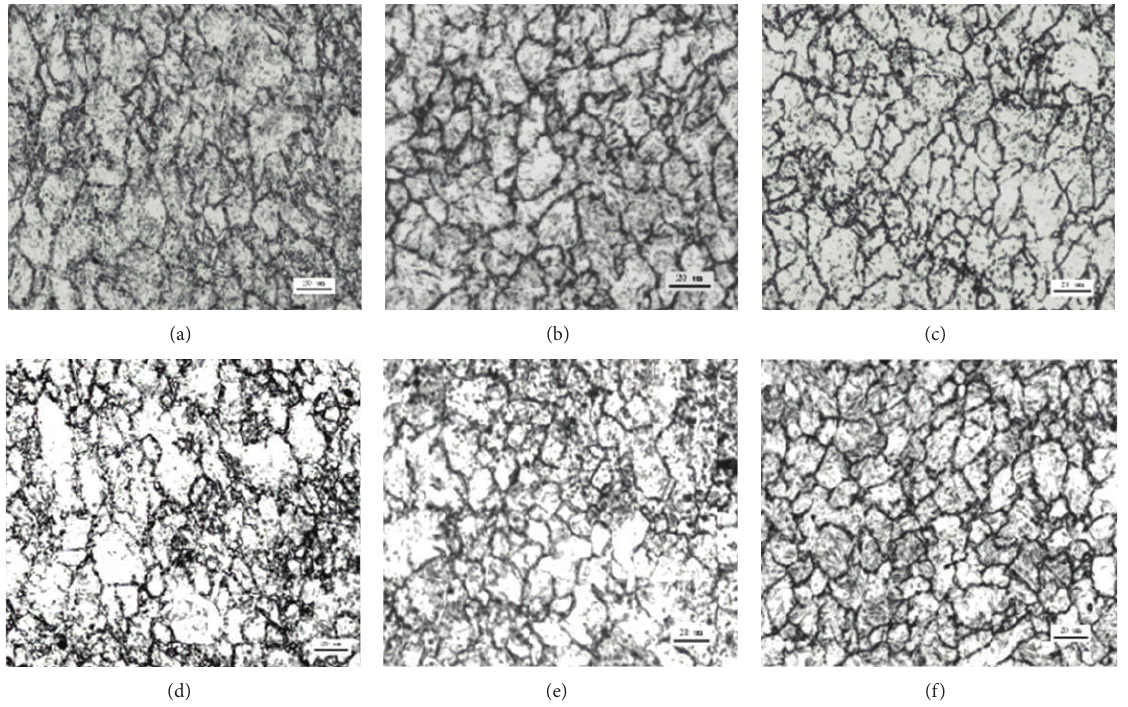
Figure 3: Microstructures obtained under different deformation conditions. (a) 𝑇 = 800 ∘ C, 𝜀 = 0.22 , and 𝑡 = 10 s; (b) T = 800 ∘ C, 𝜀 = 0.22 , and 𝑡 = 100 s; (c) 𝑇 = 800 ∘ C, 𝜀 = 0.22 , and 𝑡 = 200 s; (d) 𝑇 = 850 ∘ C, 𝜀 = 0.22 , and 𝑡 = 10 s; (e) 𝑇 = 800 ∘ C, 𝜀 = 0.35 , and 𝑡 = 10 s; (f) 𝑇 = 850 ∘ C, 𝜀 = 0.35 , and 𝑡 = 30